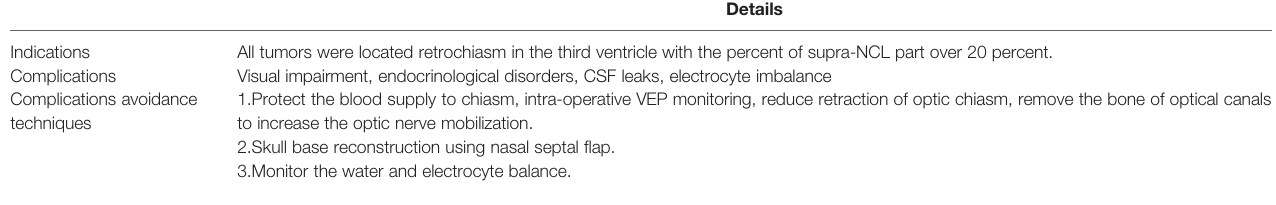
TABLE 3 | The indications and complications of EEA TLTA for tumors extended into third ventricle.